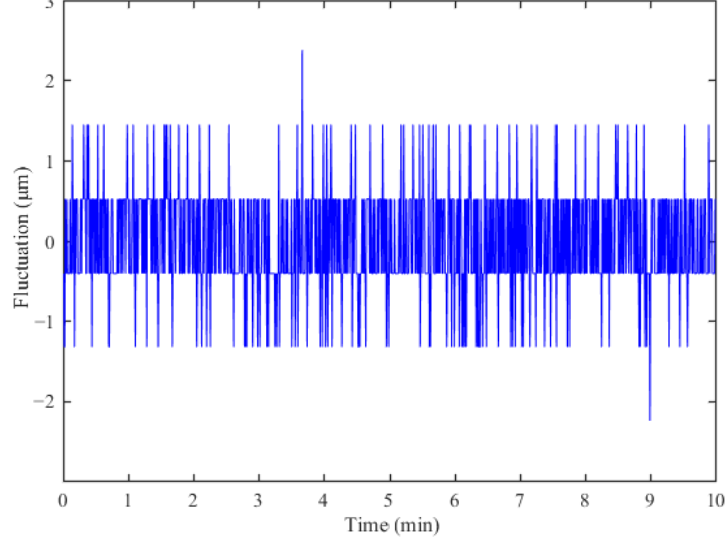
Figure 9. Measurement stability.